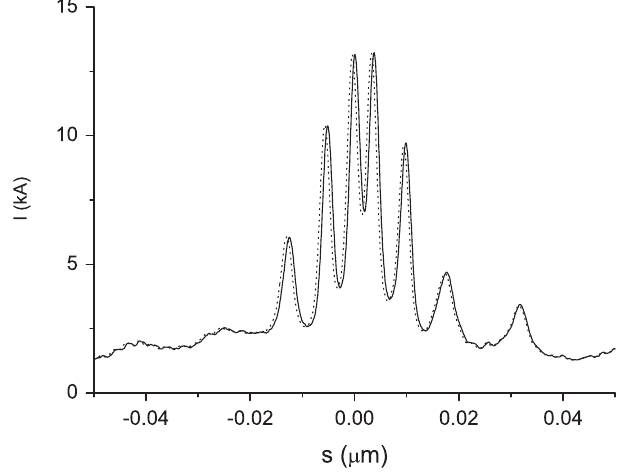
FIG. 9. Results of simulations with CSRTRACK and ASTRA . Zoomed high-current part of the bunch after the fourth chicane for the cases when CSR is off (solid line) and on (dots). The input distribution was simulated with ASTRA (but the number of particles was reduced in CSRTRACK